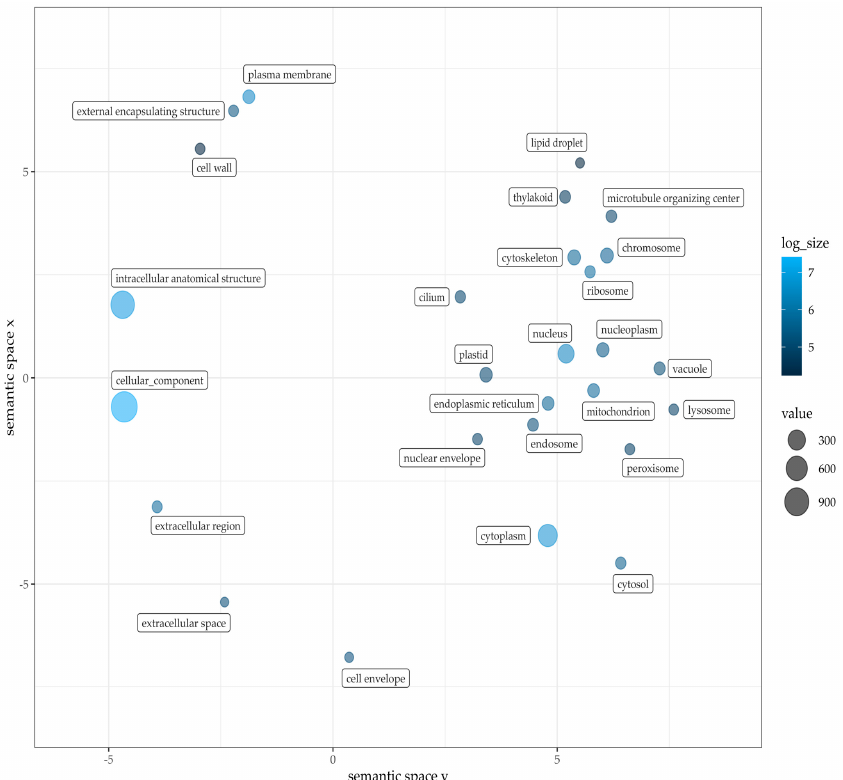
Figure 6. Gene Ontology term classification within cellular components of Pink Perfection. Figure was drafted employing REVIGO [59] and customized with R. Value and log size represent the counted GO terms across annotated gene models. Plants 2023 , 12 , x FOR PEER REVIEW